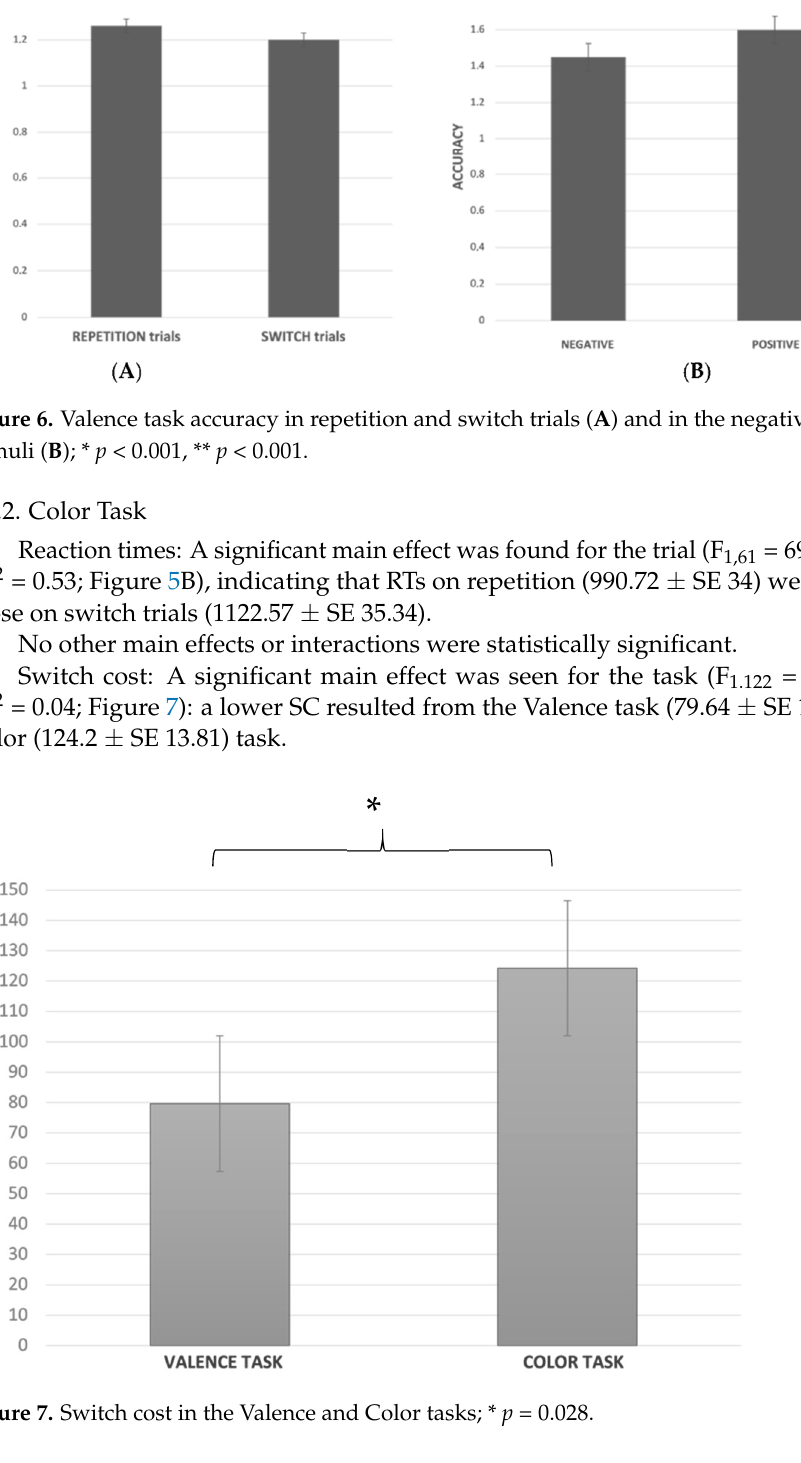
Figure 5. Reaction time (in ms) in the Valence and Color task ( A ); reaction time in the repetition and switch trials ( B ); * p < 0.001, ** p < 0.001.